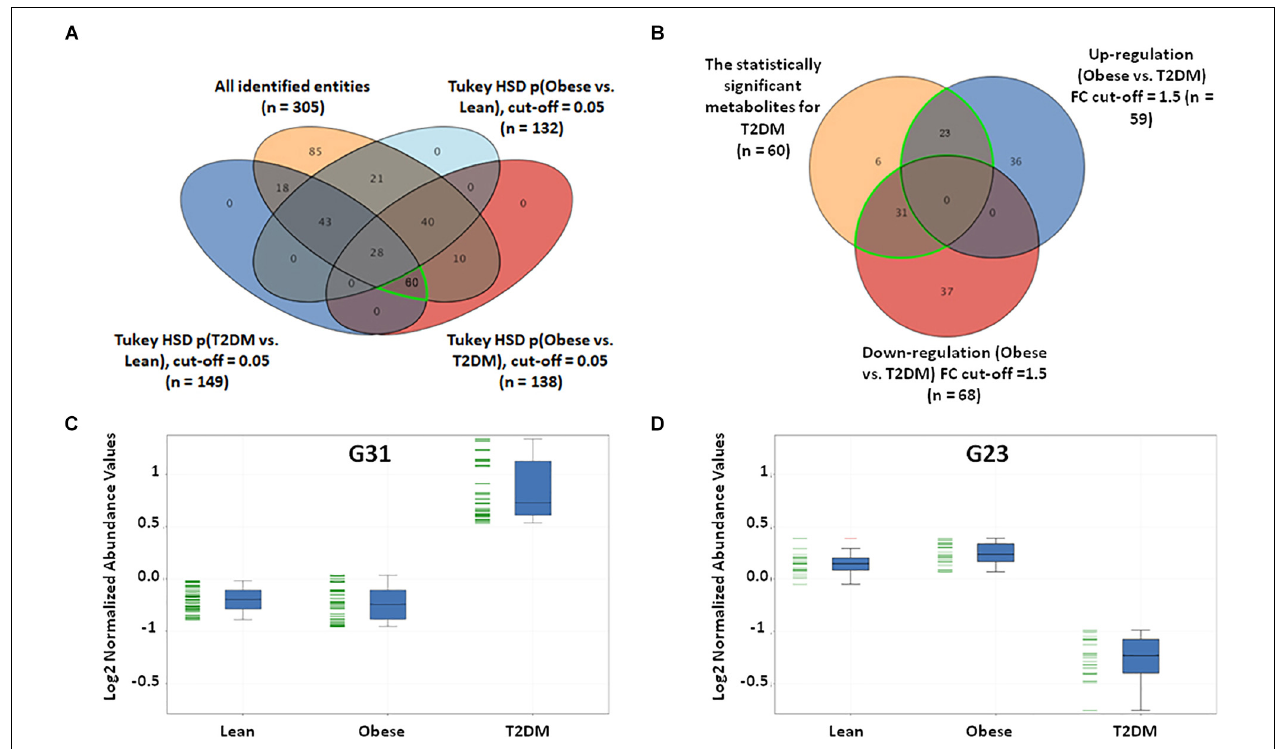
FIGURE 3 | T2DM metabolic model based on the identified features only. (A) Among the positively identified metabolites, 62 features were considered T2DM metabolic profile, where they are statistically significant between lean and T2DM, and obese and T2DM, and insignificant between lean and obese (FDR-corrected p -value < 0.051). (B) Fold change analysis (cutoff 13) separates these 62 significant metabolites into up- and down-regulated in T2DM compared to both lean and obese groups (31 and 23 metabolites, respectively). (C) Representative profile of the up-regulated (G31) and (D) down-regulated (G23)